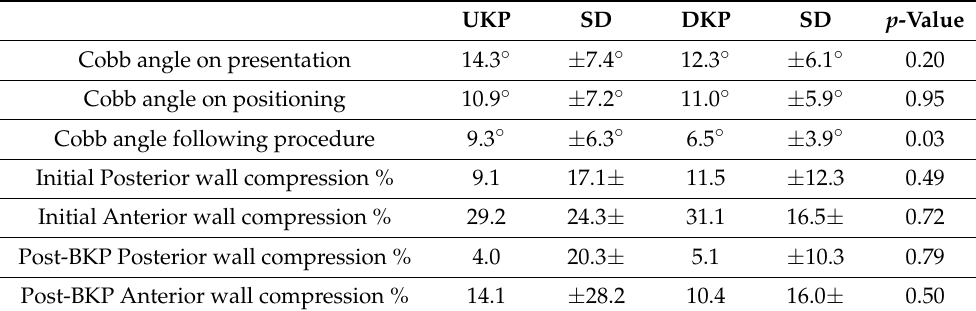
Table 1. Balloon kyphoplasty radiographic parameters (average).